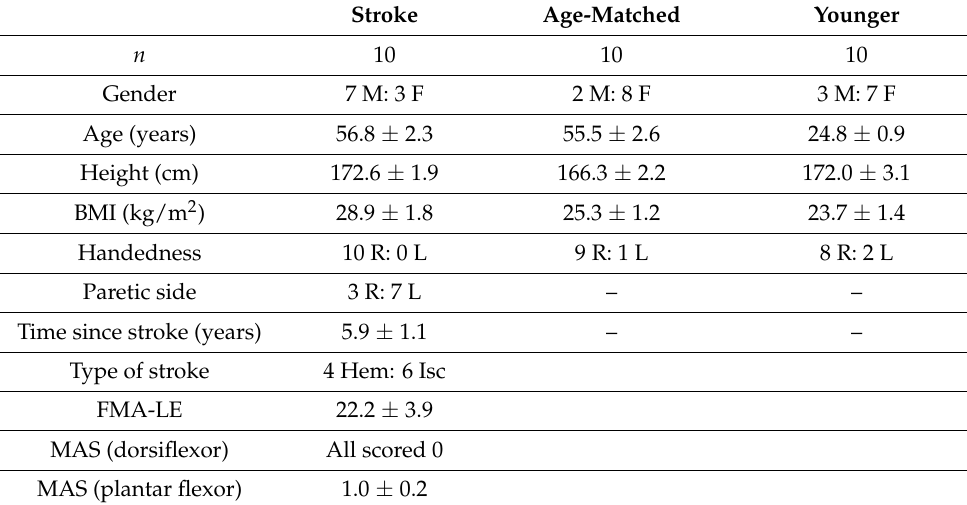
Table 2. Demographic information about study